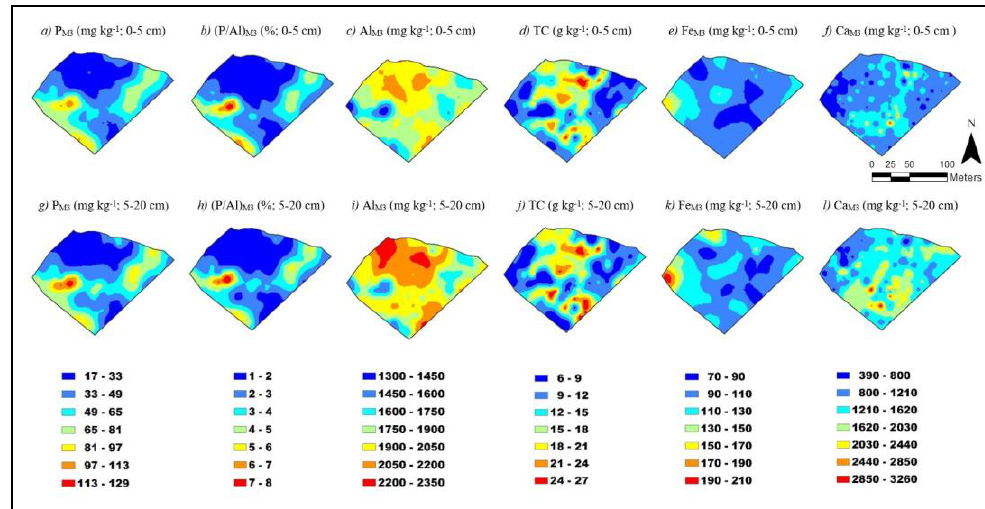
Figure 2. Spatial distribution maps of P M3 ( a , g ), (P/Al) M3 ( b , h ), Al M3 ( c,i ), TC ( d , j ), Fe M3 ( e , k ), and Ca M3 ( f , l ) for the 0 – 5 cm and 5 – 20 cm soil layers, respectively, from the young grassland field in 2013.